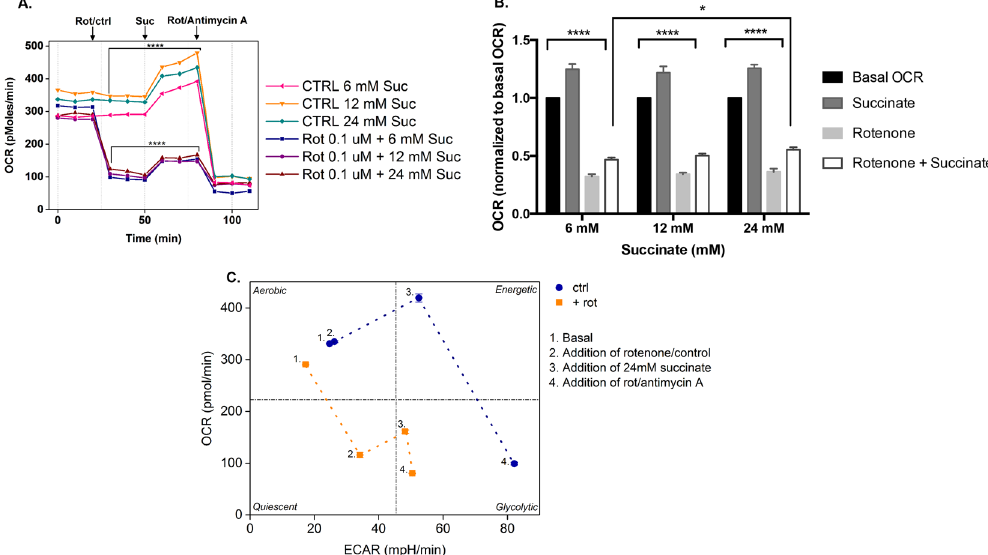
Figure 2. Effect of rotenone and succinate on oxygen consumption rate of mixed glia cultures. Oxygen consumption rate (OCR) was measured at 10 min intervals using a Seahorse Extracellular Flux XF24 analyser, in response to treatment with 0.1 µ M rotenone (Rot; mitochondrial complex I inhibitor) (or regular assay medium in the control wells) followed by addition of succinate (Suc; 6, 12, 24 mM) and, finally, after oxidative metabolism is blocked by the addition of rotenone plus antimycin A (mitochondrial complex III inhibitor) in the final three measurements. ( A ) OCR profile over the course of the experiment; ( B ) Highlight of the effect of succinate on basal OCR under control conditions (addition of assay medium) and in the presence of succinate alone, 0.1 µ M rotenone alone, or after the sequential addition of rotenone and different concentrations of succinate, as indicated. Statistically significant differences in OCR were observed between control samples and cells treated with succinate, rotenone, or succinate + rotenone for all succinate concentrations tested; furthermore, when comparing the ability of succinate to increase OCR after rotenone treatment, its effect at 24 mM was significantly higher than that induced by 6 mM. A 2-way ANOVA followed by Tukey’s multiple comparisons test was used and simple effects within columns and rows were analysed. Statistical significance is denoted as follows: P ≤ 0.05 ( * ) and P ≤ 0.0001 ( **** ). ( C ) Metabolic phenotype plot of OCR vs. extracellular acidification rate (ECAR). Data are from the same wells as in ( A ). Blue circle symbols indicate control wells: (1) basal conditions, (2) addition of control assay medium, (3) addition of 24 mM succinate, (4) addition of rotenone plus antimycin A. Orange square symbols indicate experimental wells: (1) basal conditions, (2) addition of 0.1 µ M rotenone, (3) addition of 24 mM succinate, (4) addition of rotenone plus antimycin A. Units of OCR are picomol/min and ECAR milli-pH units/min; values are mean (n ≥ 3) ± standard error of the mean